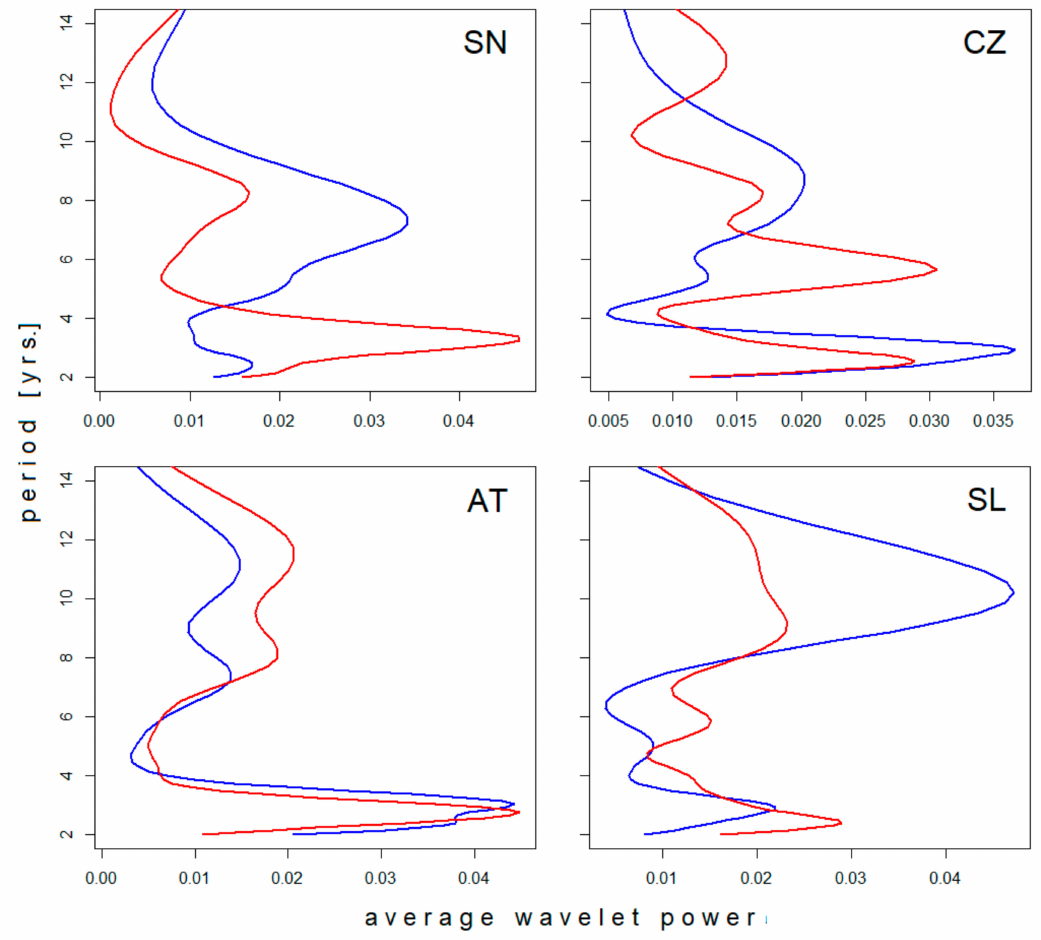
Figure 2. Comparison of average wavelet power spectra of tick-borne encephalitis (TBE) fluctuations in (blue) the pre-warming- and (red) post-warming periods in (SN) Sweden, (CZ) the Czech Rep., (AT) Austria, and (SL) Slovenia. For presentation, the spectra were normalized resulting in unitary area under the curve. Note a systematic shift towards longer periods of oscillation in the pentennial–decadal band contrasting with only erratic variations in the biennial–triennial band (best seen in Austria). Changes in the TBE cycles with respect to their amplitude and contribution to an overall disease variance are summarized in Figure 3. It is evident that, in absolute terms, an increment of power between the ‘pre-’ and ‘post-warming’ periods systematically decreases from the shortest to the longest oscillations. In relative terms, the short cycles became, on average, augmented, and the long cycles damped, compared to the ‘pre-warming’